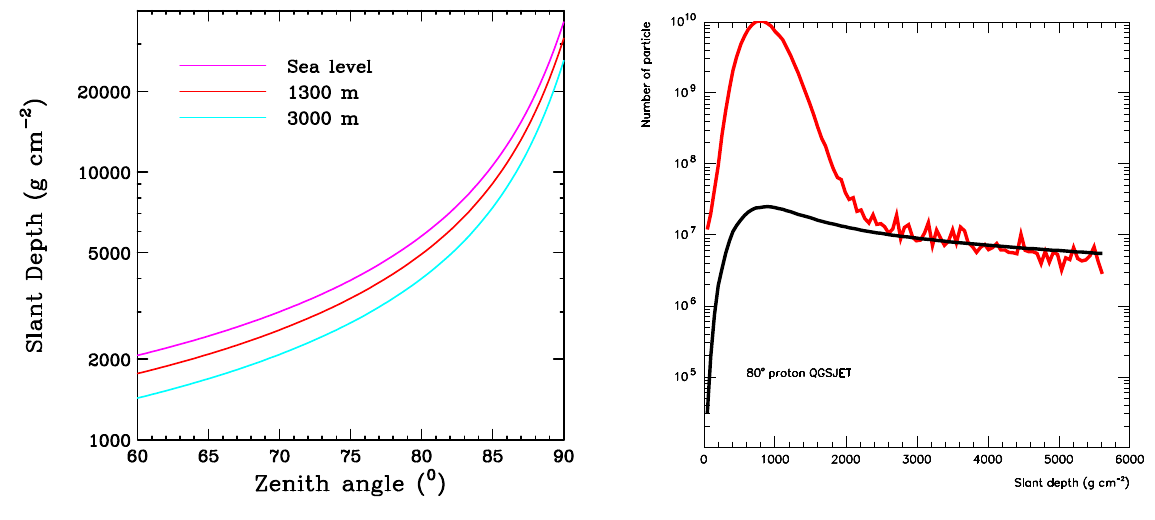
Figure 4. Left: slant depth as a function of zenith angle for three di ff erent altitudes: from top to bottom sea level, 1300 and 3000 m. Right: depth development of electromagnetic (red) and muonic (black) components of a typical shower induced by a proton (qualita- tively identical to that induced by a nucleus). The electromagnetic component for slant depth larger than 2000 g · cm 2 is dominated by a halo produced by the decay of low energy muons, bremsstrahlung and pair production, not detectable by particle detectors. Taken from